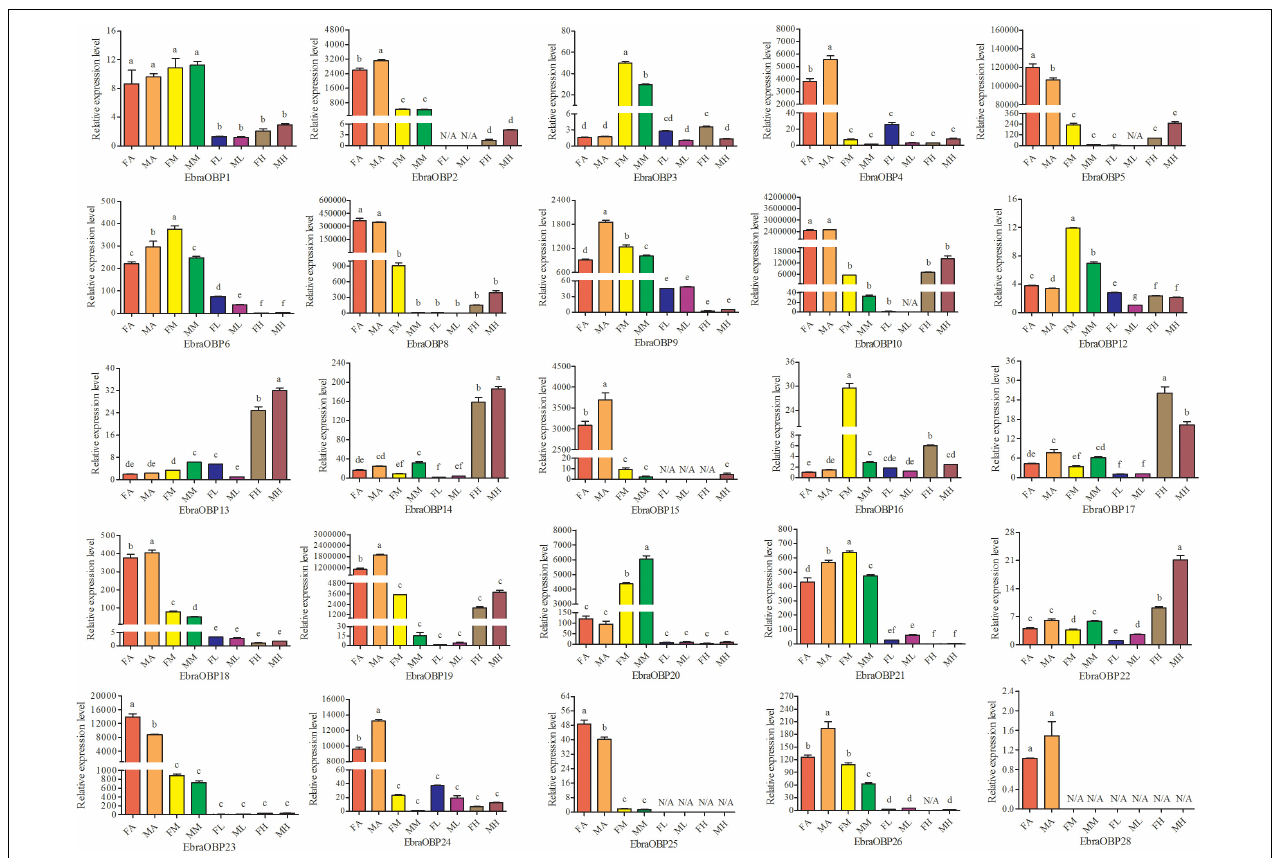
FIGURE 7 | Relative expression levels of E. brandti OBPs in different tissues of female and male adults by RT-qPCR. FA, female antennae; MA, male antennae; FM, female rostrums; MM, male rostrums; FL, female legs; ML, male legs; FH, female head (with antennae and rostrum cut off); MH, male head (with antennae and rostrum cut off). The bar represents standard error and the different small letters (a–g) above each bar indicate significant differences ( P < 0.05). N/A indicates that the transcript level is too low to